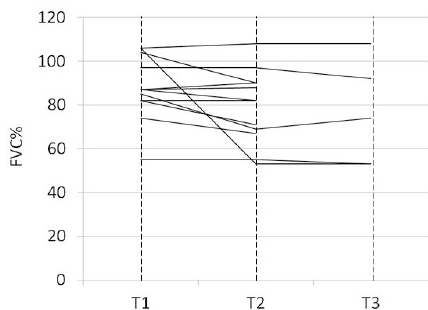
Figure 1. Change in forced vital capacity (FVC)% predicted under pirfenidone and nintedanib treatment. Each line represents one individual patient. T1 = Time-point 1, under ongoing pirfenidone treatment 12-months prior to switch to nintedanib; T2 = Time-point 2, 12-months later at the time the switch was made; T3 = time-point 3, 12-months after the patient initiated nintedanib treatment.